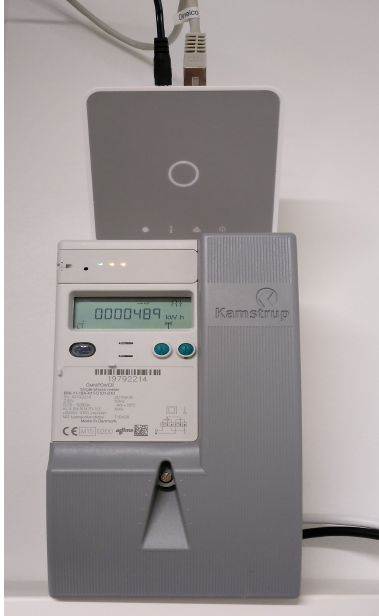
Figure 10. Kamstrup Smart meter.